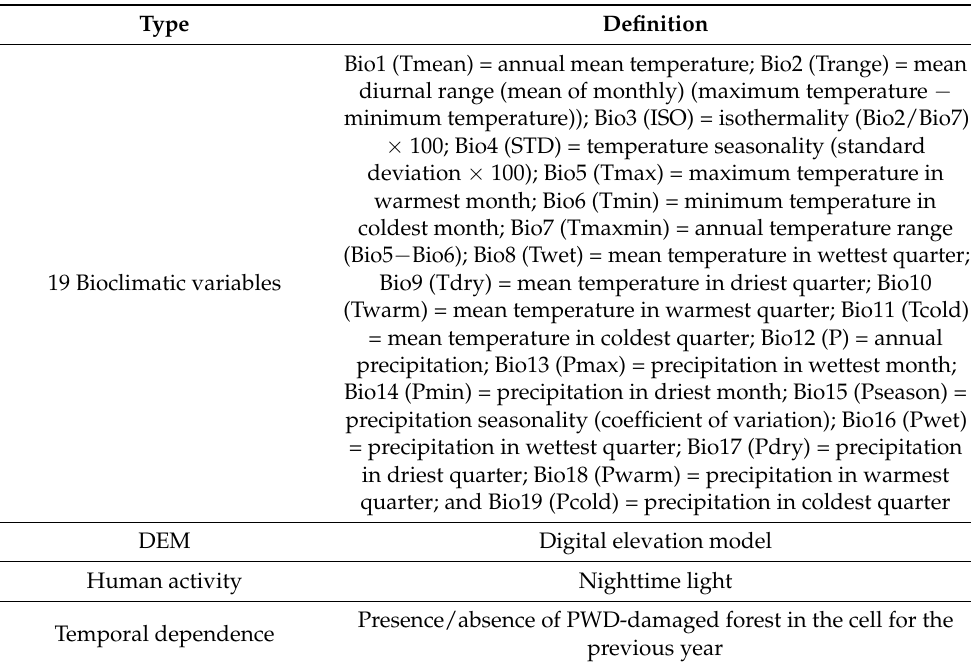
Table 1. Environmental factors used to predict potential PWD-damaged forest distribution in this